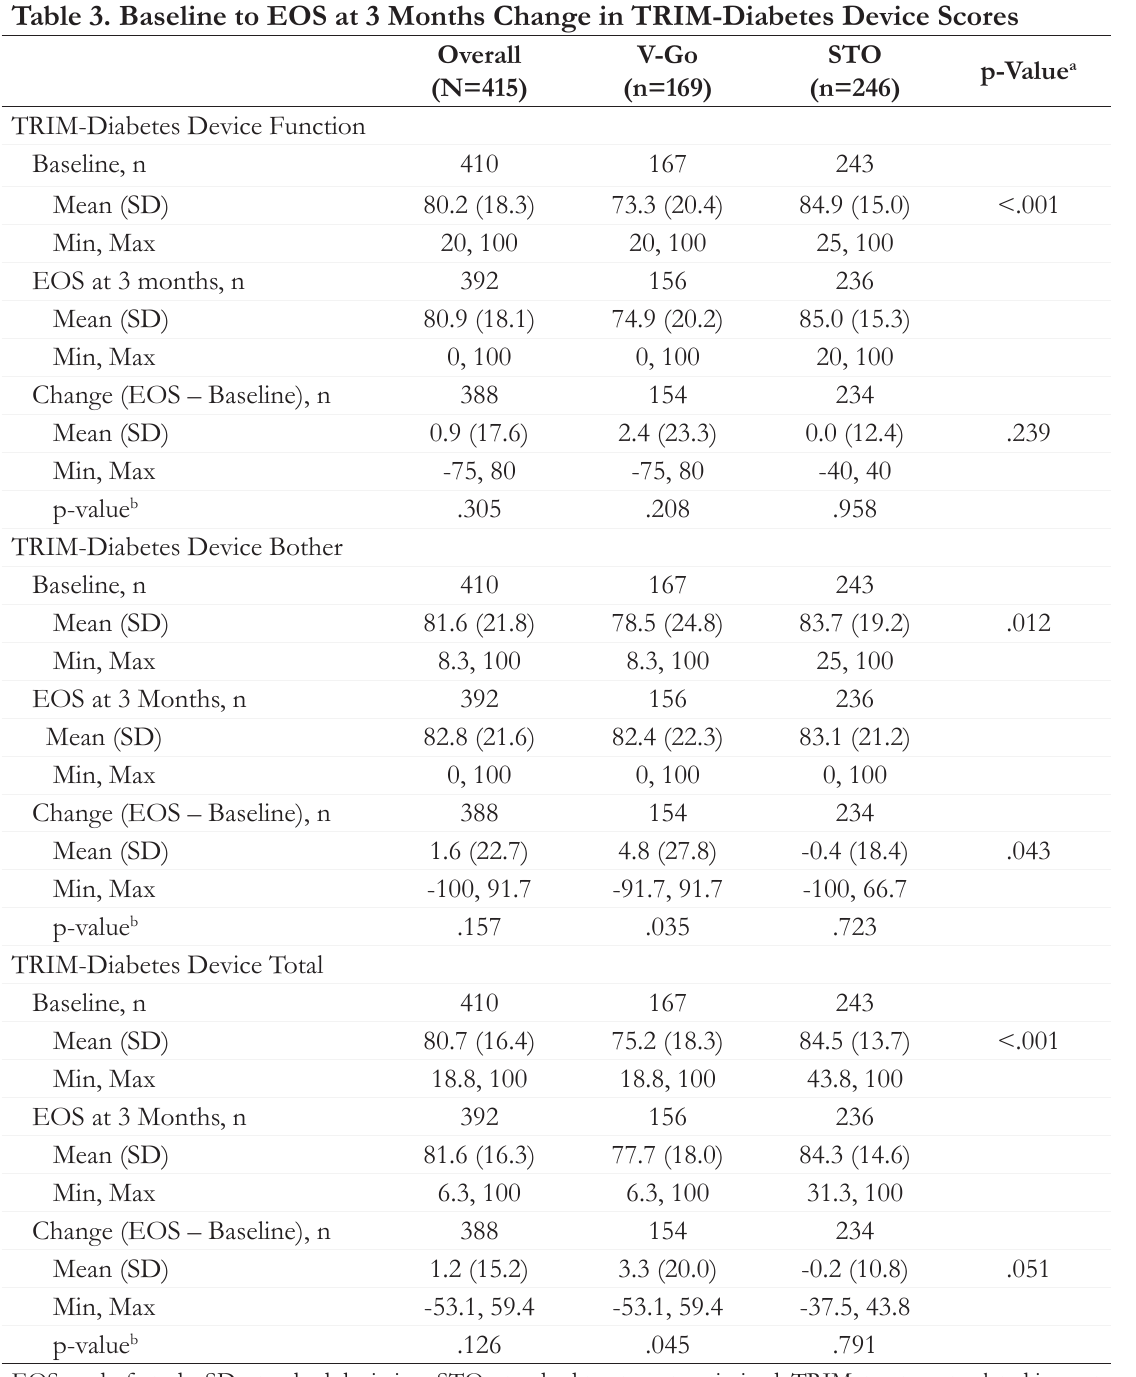
Table 3. Baseline to EOS at 3 Months Change in TRIM-Diabetes Device Scores